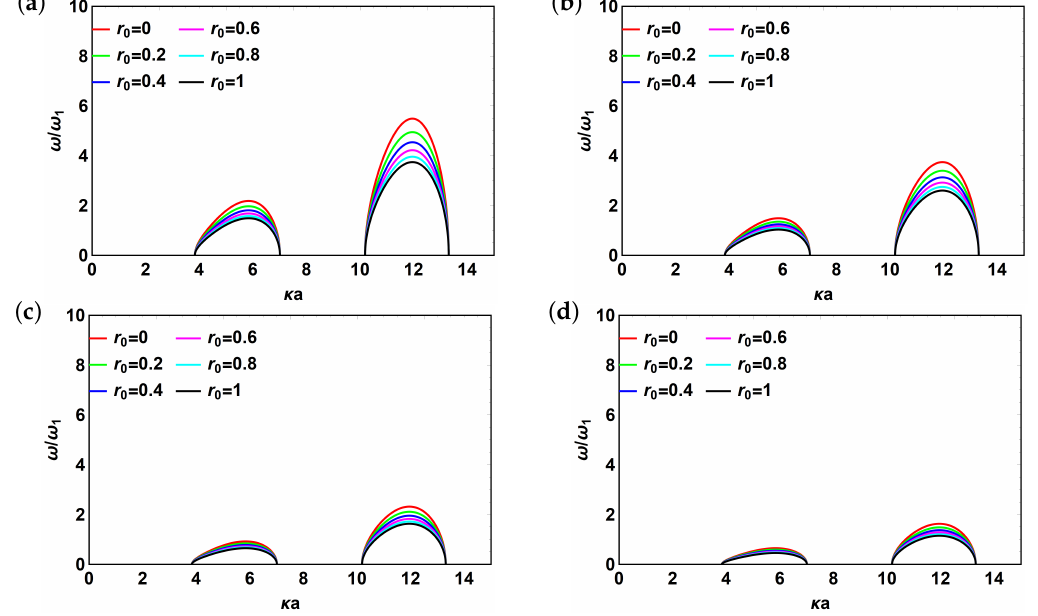
Figure 7. Dispersion relation for metascreen w/1 interface and w/reflector ( a ) q = 1, p = 3; ( b ) q = 2, p = 3; ( c ) q = 5, p = 3; ( d ) q = 10, p = 3. For all plots n = 1, r 0 = 0.5, kh (cid:28) 1, δ (cid:28) 1. “Positive” branch only is